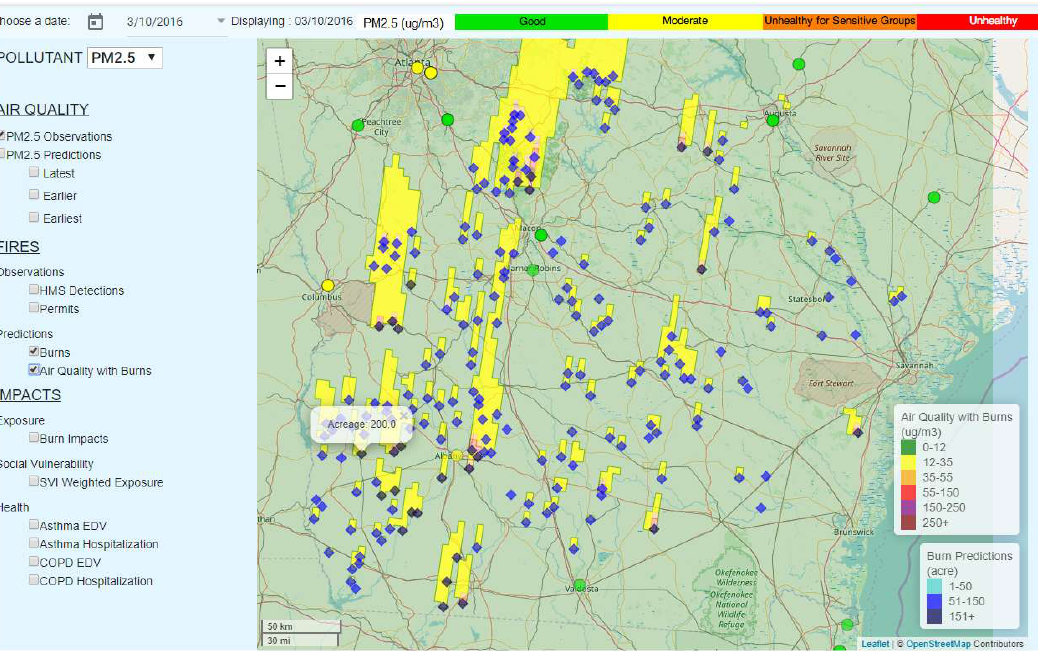
Figure A4. SIPFIS webpage displays forecast burns, overlaid with PM 2.5 forecast levels including the impact of